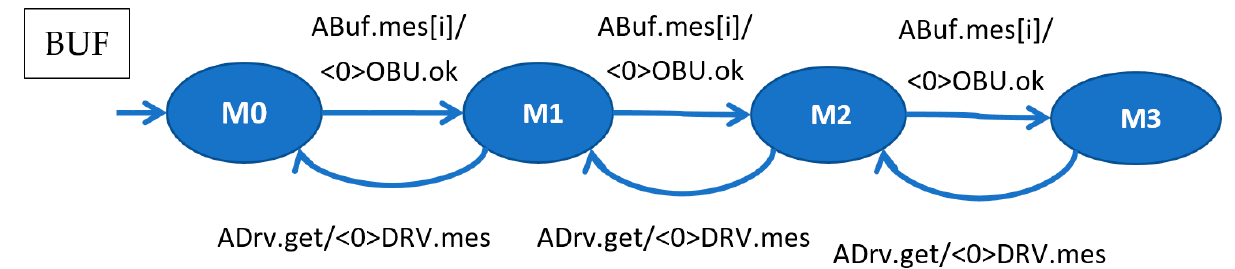
Figure 11. The automaton modeling the buffer, BUF .